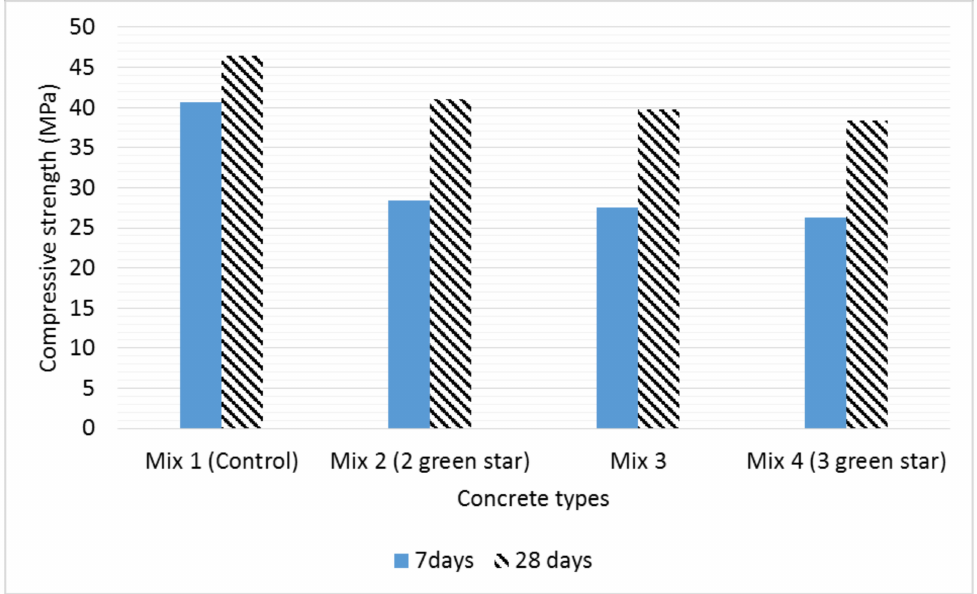
Figure 4. Measured compressive strength of green star concretes and control